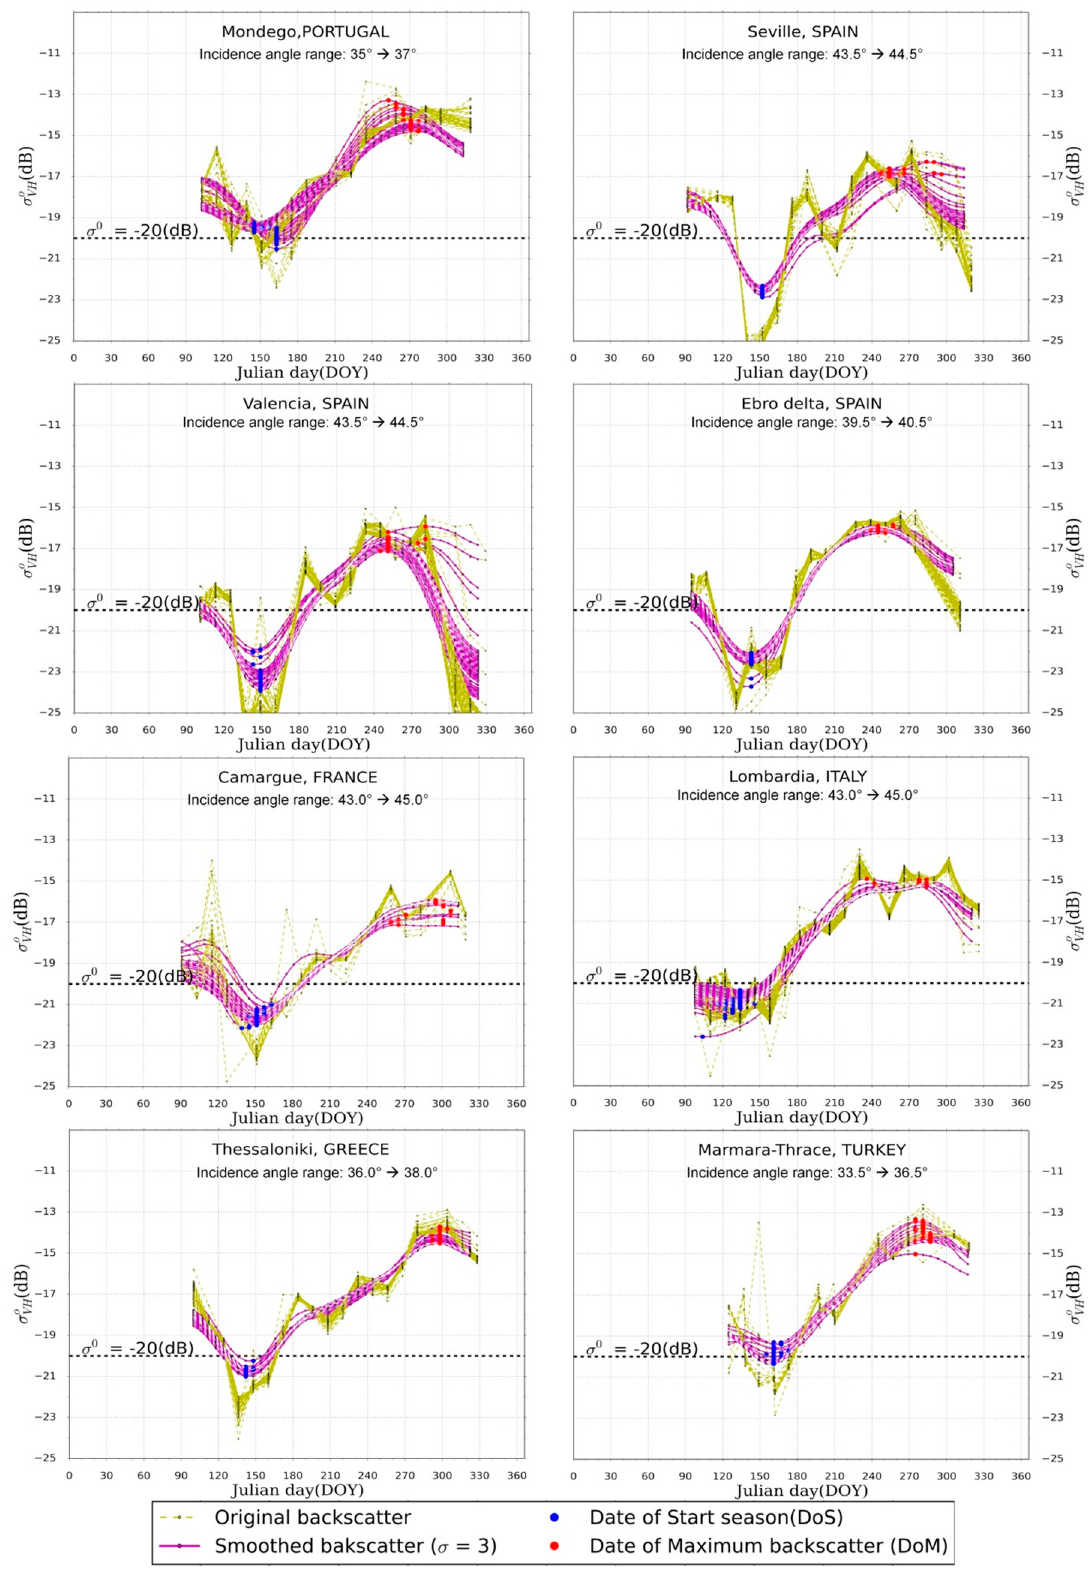
Figure 8. Temporal evolution of the backscattering coefficients derived from VH polarization (where, σ o (cid:2026) (cid:3023)(cid:3009)(cid:3042) (cid:3404) −20 (cid:4666)dB(cid:4667) is base line). VH